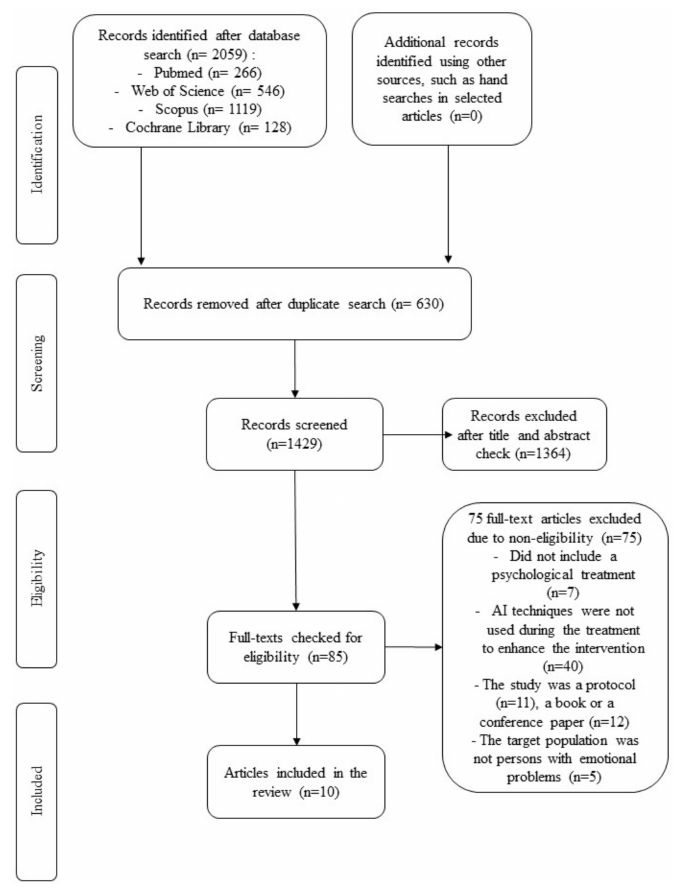
Figure 1. Selection progress of the